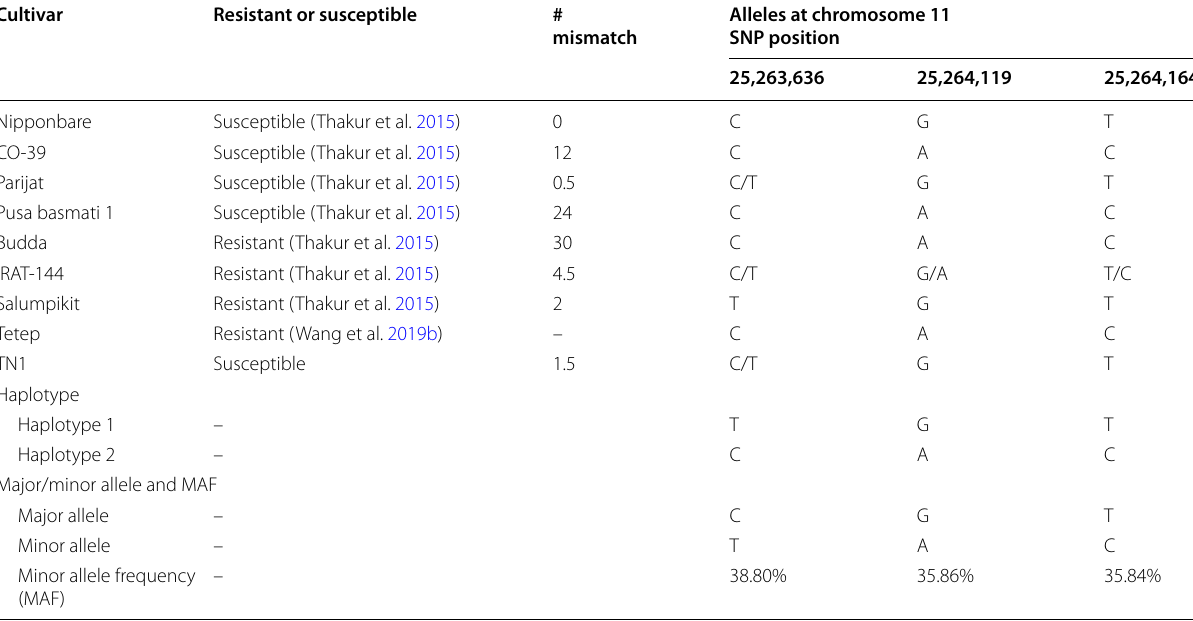
Table 2 Pi54 alleles of blast susceptible and resistant cultivars at the same SNP